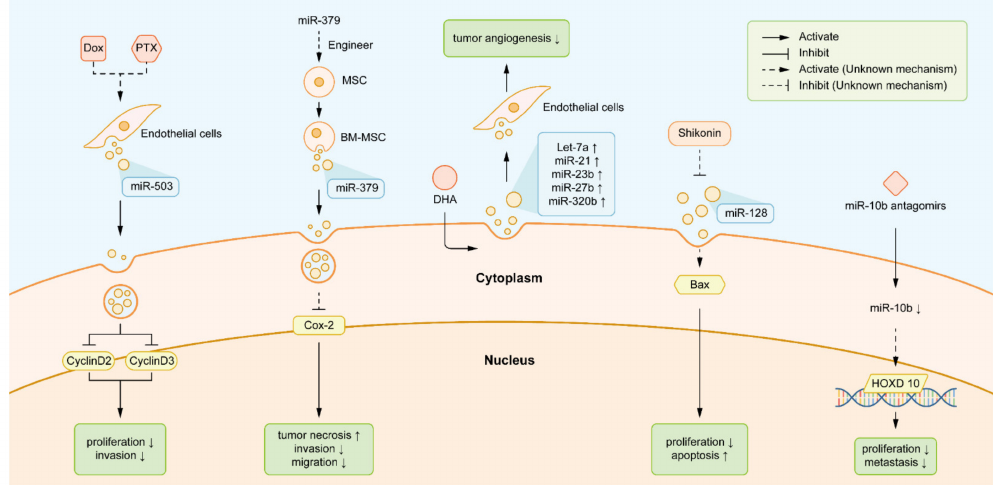
Figure 3. Exosomal miRNAs as novel targets for targeted therapy. The text legends from left to right are: (a) DOX and PTX induced endothelial cells to deliver more exosomal miR-503. The increased miR-503 interrupted the expression of CCND2 and CCND3, inhibiting BC cell proliferation and invasion consequently. (b) Engineering MSCs carried more exosomal miR-379 and released it into the tumor micro-environment by BM-MSCs, which interfered with the migration capacity of BC and induced the apparent tumor lesion necrosis. (c) DHA induced the elevated level of some exosomal miRNAs with negative effects on angiogenesis and tumorigenesis, such as let-7, miR-21, miR-23b, miR-27b, and miR-320b. (d) Shikonin inhibited the secretion of exosomal miR-128 in breast cancer cells, thus lifting its inhibition to the expression of the apoptotic gene Bax. Shikonin modified the interaction between exosomal miR-128 and Bax, subsequently promoting apoptosis. (e) MiR-10b antagomirs directly attenuated the bioactivities of exosomal miR-10b, which subsequently promoted the translation of HOXD10 and suppresses the migration of BC. Abbreviations: DOX: doxorubicin. PTX: paclitaxel. CCND2: cyclin D2. CCND3: cyclin D3. BC: breast cancer. MSCs: mesenchymal stem cells. BM-MSCs: bone marrow-derived mesenchymal stem cells. DHA: docosa-hexaenoic acid. HOXD10: Homeobox